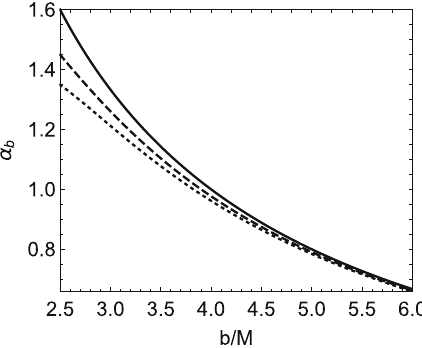
Fig. 3 The dependence of the deflection angle of photon on the dimen- sionless impact parameter ( b / M ) for various values of the dimension- less “Hoˇrava” parameter ( ˜ ω ) : 10,000 (solid line), 1 (dashed line), KS 0.6 (dotted